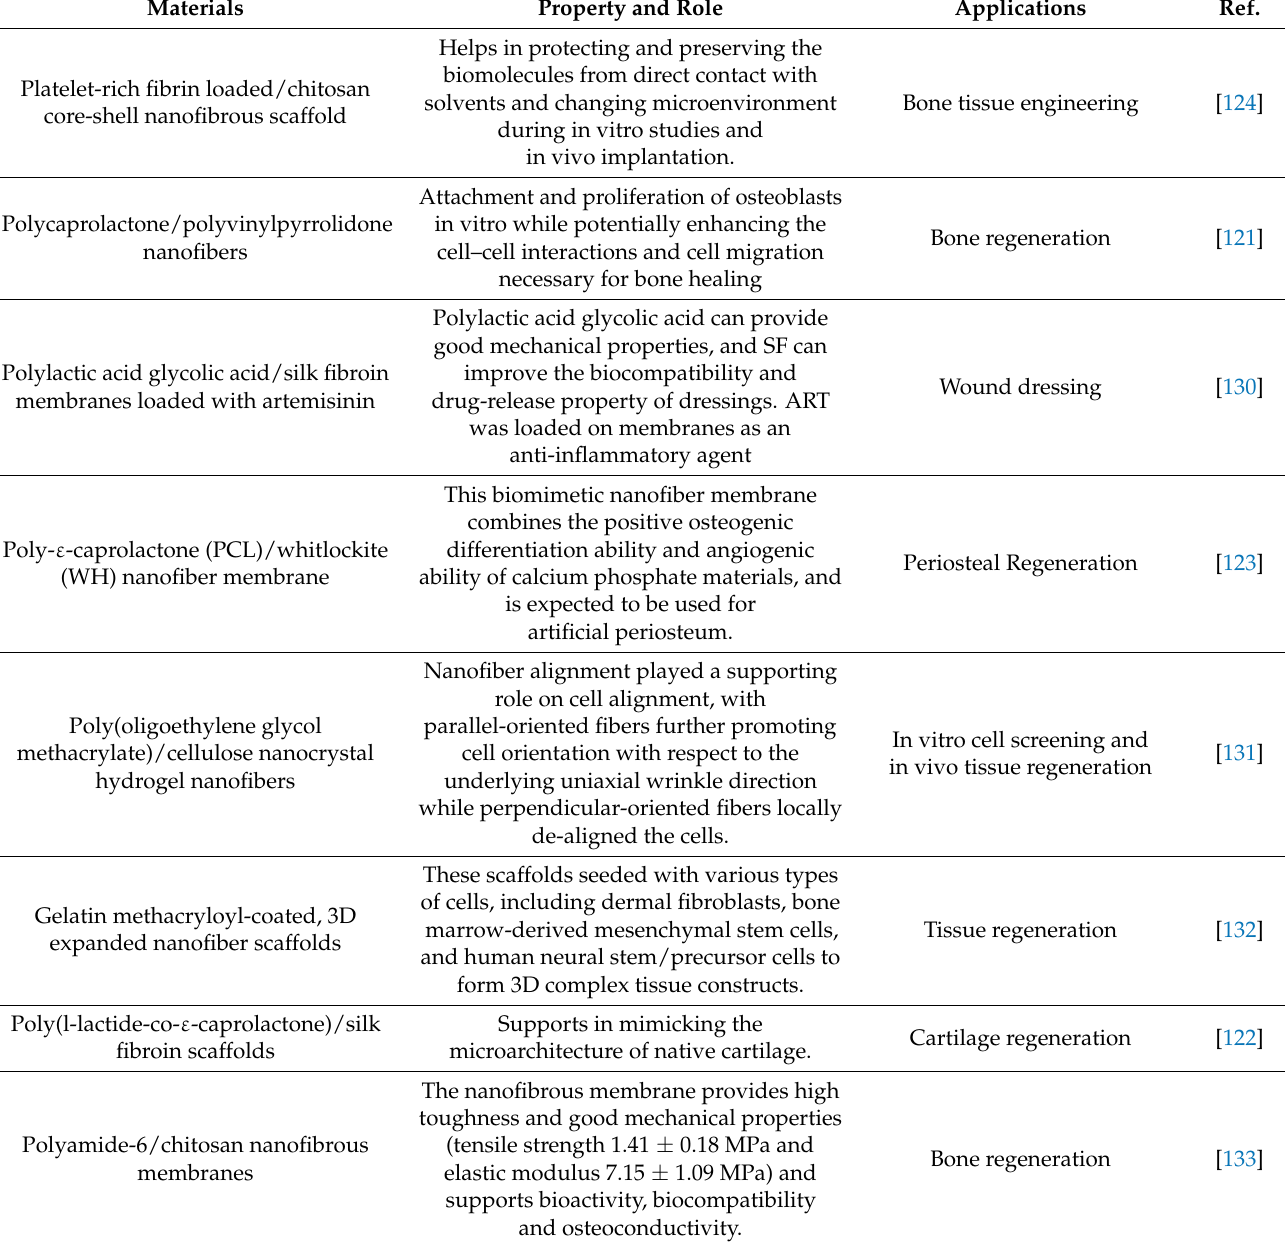
Table 2. Role of nanofiber materials in various tissue engineering